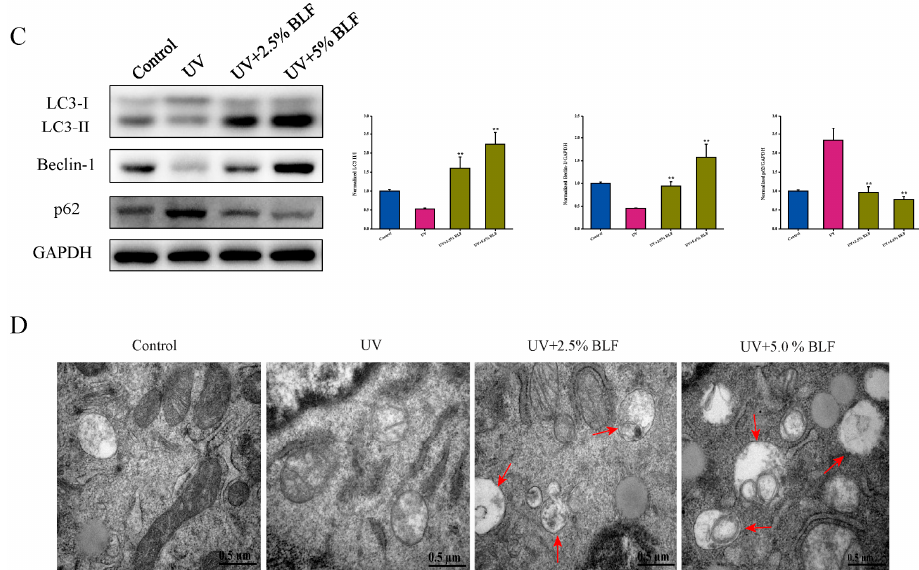
Figure 8. BLF delayed UVB-induced dorsal skin aging in mice. ( A ) Protein expression of K9M-H3, p21, and p16 determined by Western blotting. ( B ) Protein expression of p-p38, p38, p-JNK, JNK, p-ERK, and ERK determined by Western blotting. ( C ) Protein expression of LC3-I/II, Beclin-1, and p62 determined by Western blotting. Quantitation is shown on the right. ( D ) Autophagosomes detected by TEM in skin tissue. Representative images are shown. Scale bar = 0.5 µ m. ** p < 0.01 vs. UV